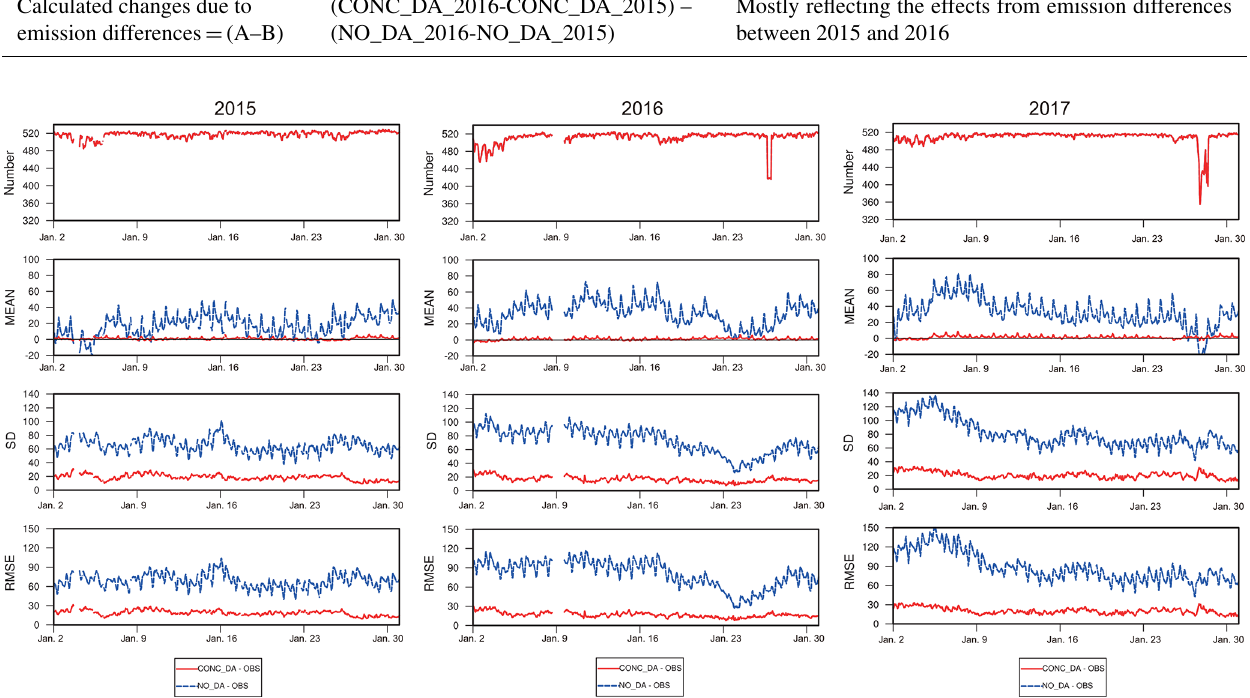
Figure 4. Time series of the statistics between the model simulations and observations. Red lines are CONC_DA minus observations, and blue lines are NO_DA minus observations. Statistics include the number of data pairs for comparison, the MEAN (mean bias), the SD (standard deviation) and the RMSE (root-mean-square error). On the left is 2015, in the middle is 2016 and on the right is 2017 (units are µgm − 3 for MEAN, SD and